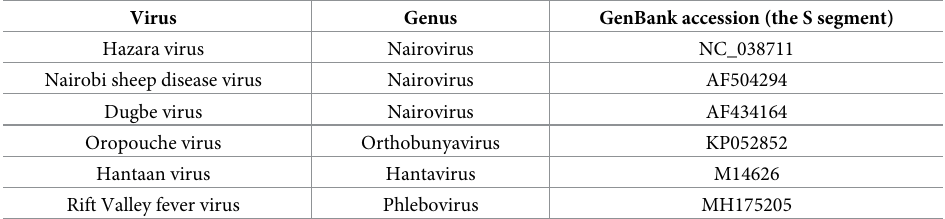
Table 3. CCHFV-related viruses (Family